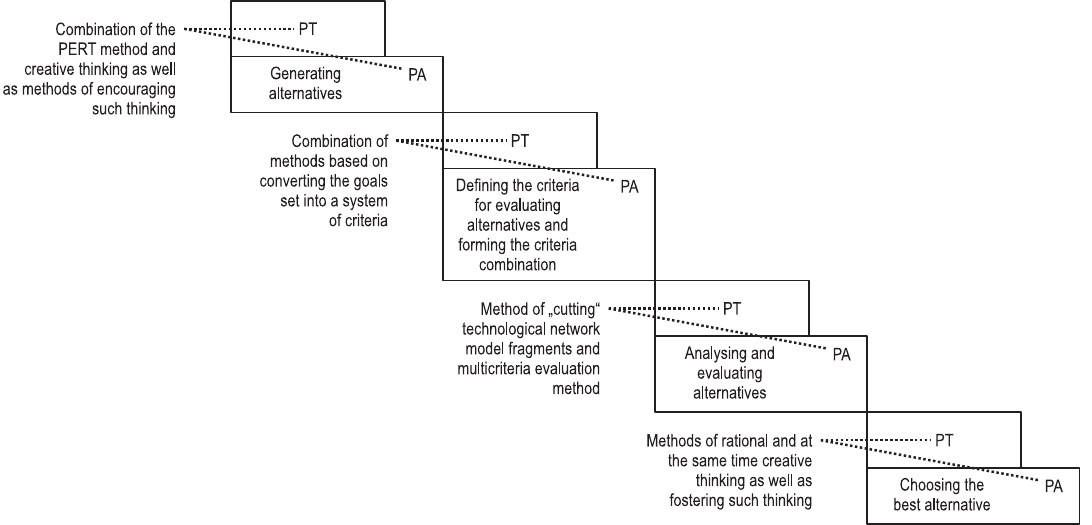
Fig 6. Scheme of working out an action plan for implementing strategic